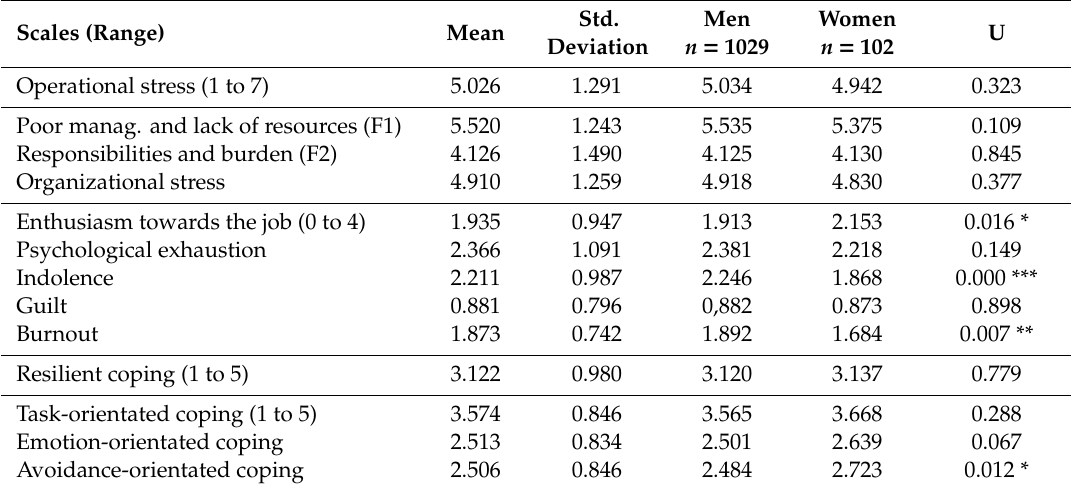
Table 4. Descriptive and comparative statistics for job stress, burnout and coping. Scales